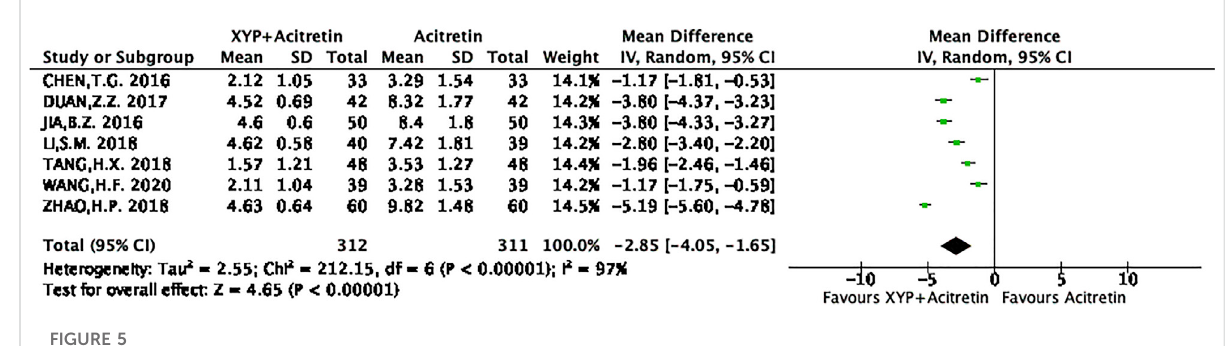
FIGURE 5 Forest plots showing the PASI